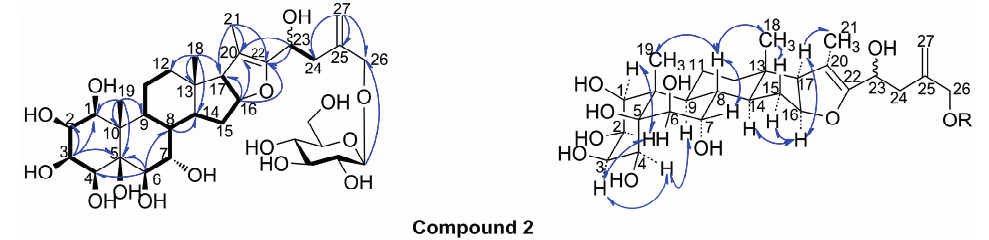
Figure 3. Key HMBC, 1 H- 1 H COSY and NOESY correlations of the compound 2